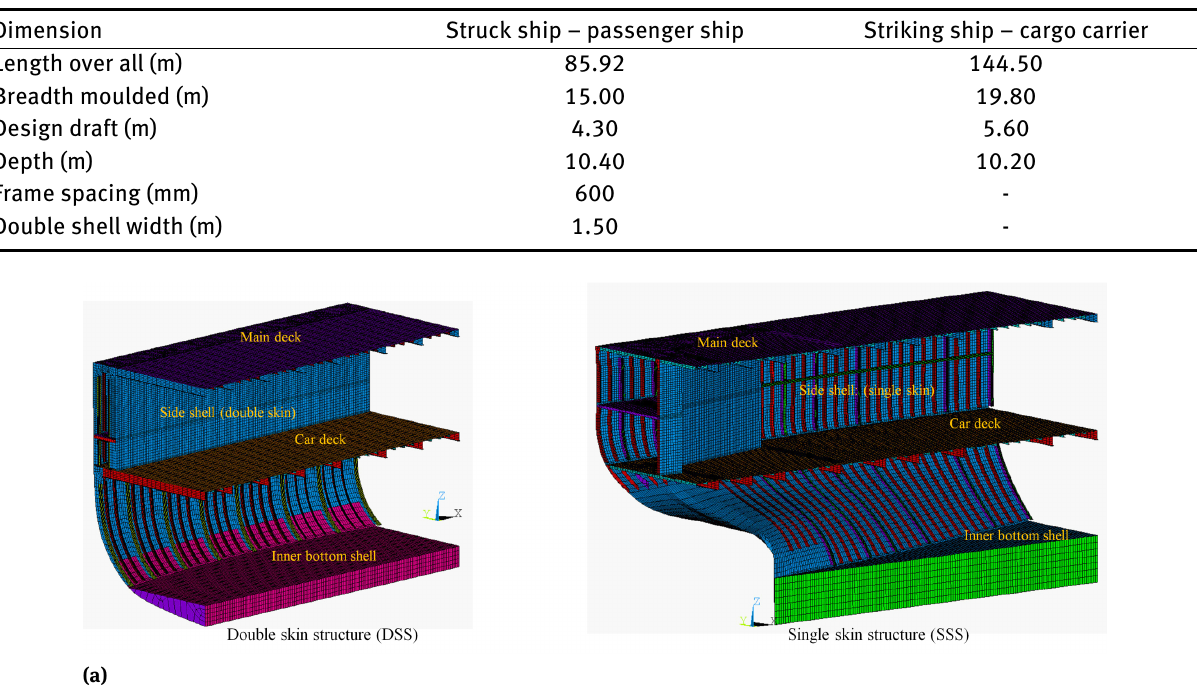
Table 2: Main dimension of the involved ships in collision analysis.